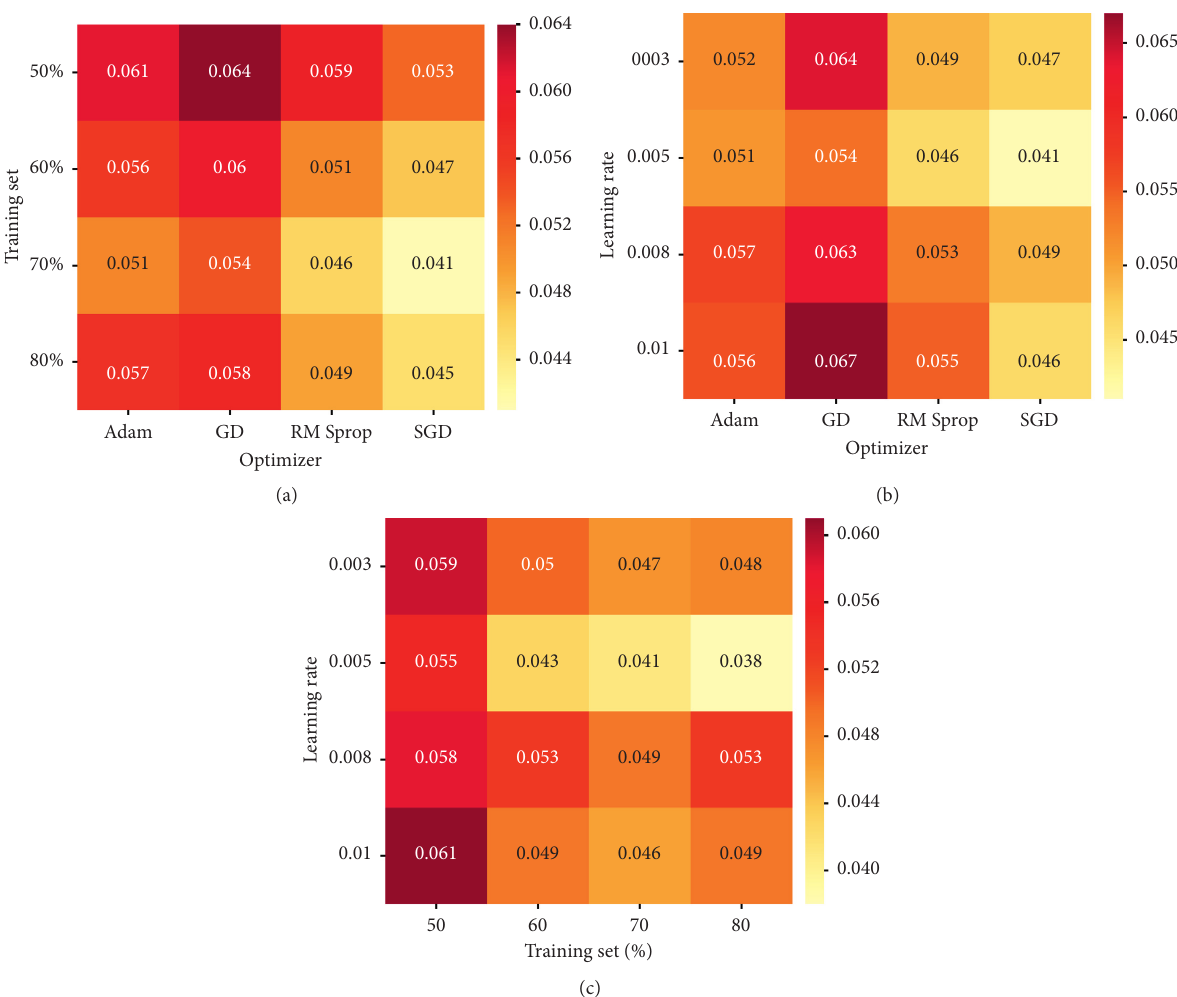
Figure 7: The MAE value of UWM-Id under different parameter combinations, (a) the training set and optimizer, (b) the learning rate and optimizer, and (c) the learning rate and training